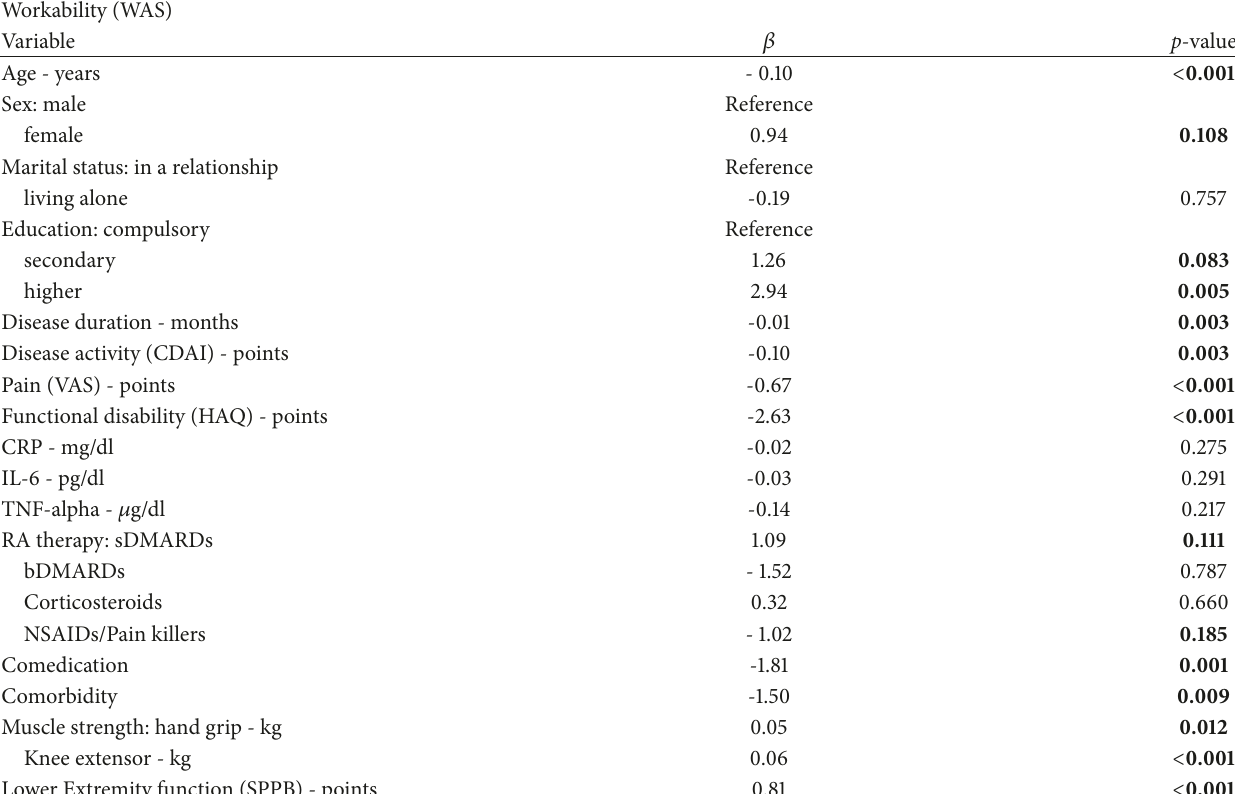
Table 3: Univariate analysis of associations between sociodemographic, clinical characteristics, and workability (workability index single item,